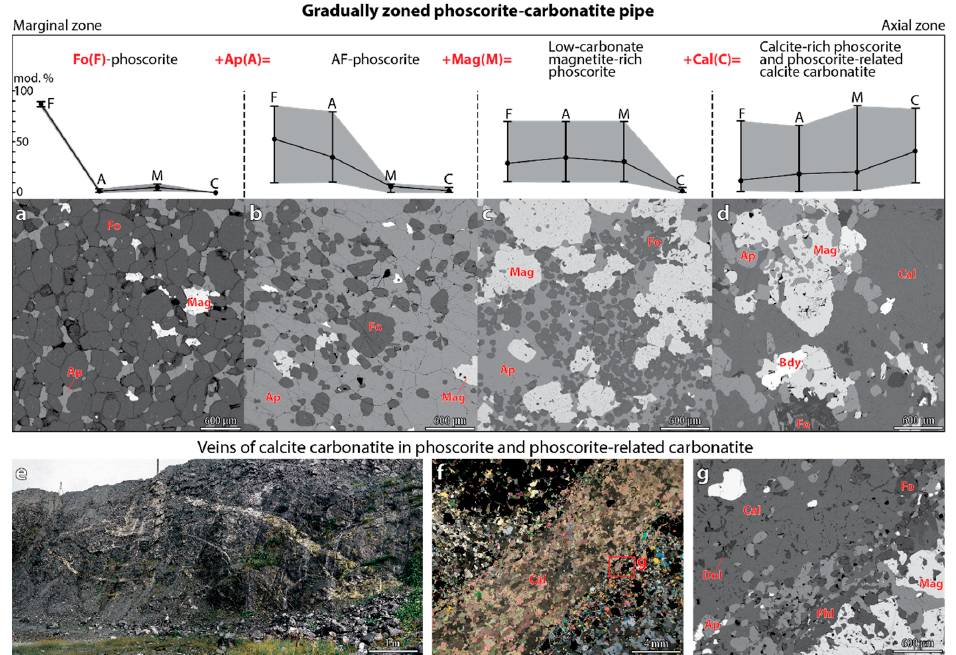
Figure 2. Relations of major rocks within the Kovdor phoscorite-carbonatite pipe. BSE-images ( a – d , g ) of main rock types, photo of outcrop ( e ) and image of thin section in transmitted light ( f ). ( a ) 914/185.2; ( b ) 993/132.3; ( c ) 981/217.1; ( d ) 1006/436.1; ( f , g ) 927/21.7. Table 1. Main varieties of phoscorite and phoscorite-related carbonatite [10].